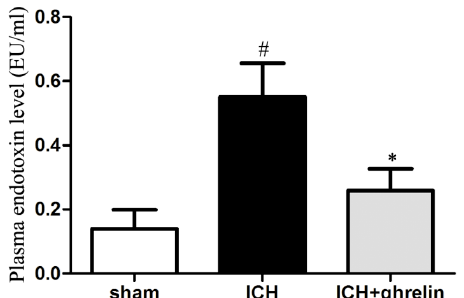
Figure 5. Ghrelin suppressed intestinal endotoxin translocation after ICH. Serum endotoxin levels were significantly higher in the ICH mice than that in the sham mice. After ghrelin administration, serum endotoxin levels were significantly reduced post-ICH. The values are the mean ± SD, n = 6, # p < 0.01 vs. sham group; * p < 0.01 vs. ICH group. The data are representative of six independent experiments performed in triplicate.